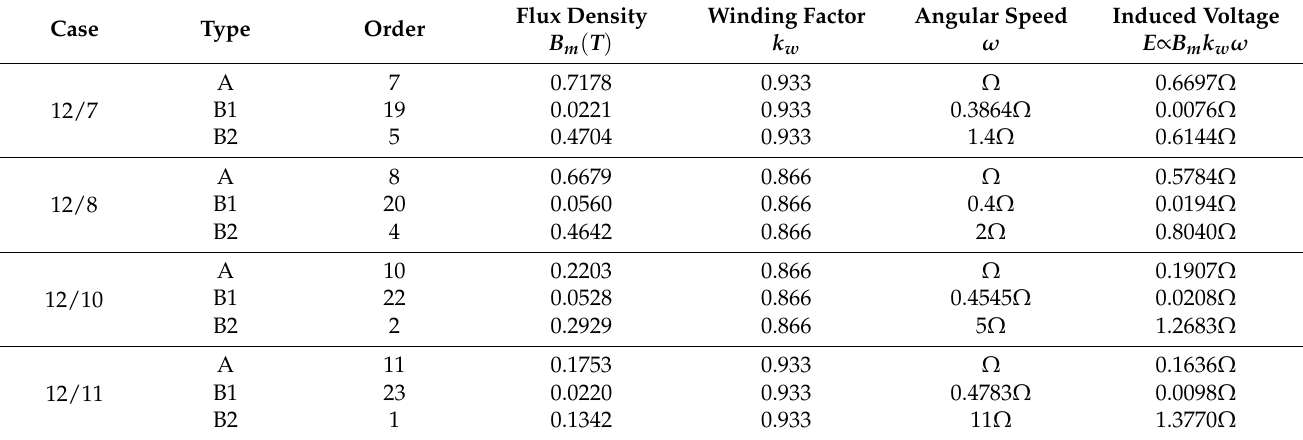
Table 4. Contribution of the harmonic components to back EMF by the analytical method.